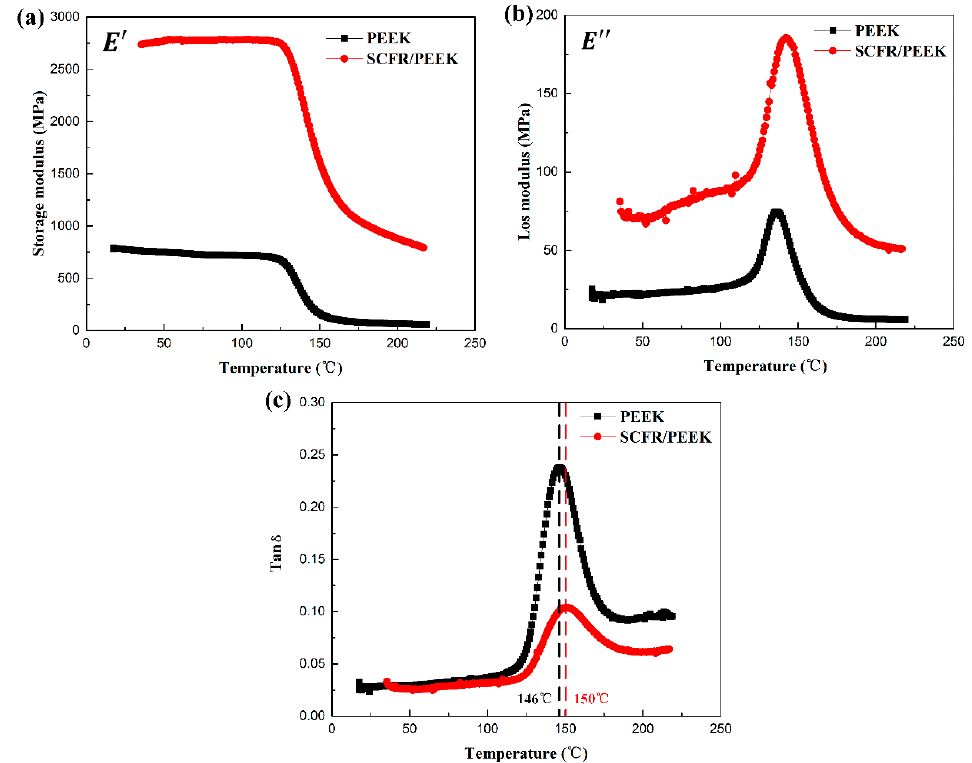
Figure 3. Dynamic mechanical analysis (DMA) results of PEEK and SCFR/PEEK composites: ( a ) the storage modulus ( E (cid:48) ) versus temperature; ( b ) the loss modulus ( E (cid:48)(cid:48) ) versus temperature, ( c ) the tan δ versus temperature.